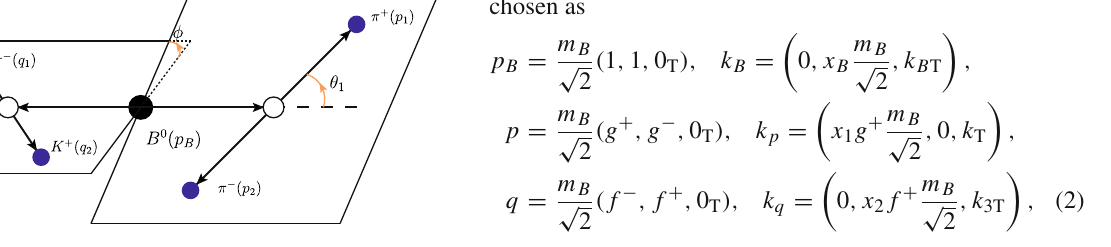
Fig. 1 Graphical definitions of the helicity angles θ 1 , θ 2 and φ . Taking the B 0 → R 1 R 2 decay as an example, with each quasi-two-body inter- mediate resonance decaying to two pseudoscalars ( R 1 → π + π − and R 2 → K + π − ), θ 1 (θ 2 ) is denoted as the angle between the directions of motion of π + ( π − ) in the R 1 ( R 2 ) rest frame and R 1 ( R 2 ) in the B 0 rest frame, and φ is the angle between the plane defined by π + π − and the plane defined by K + π − in the B 0 rest